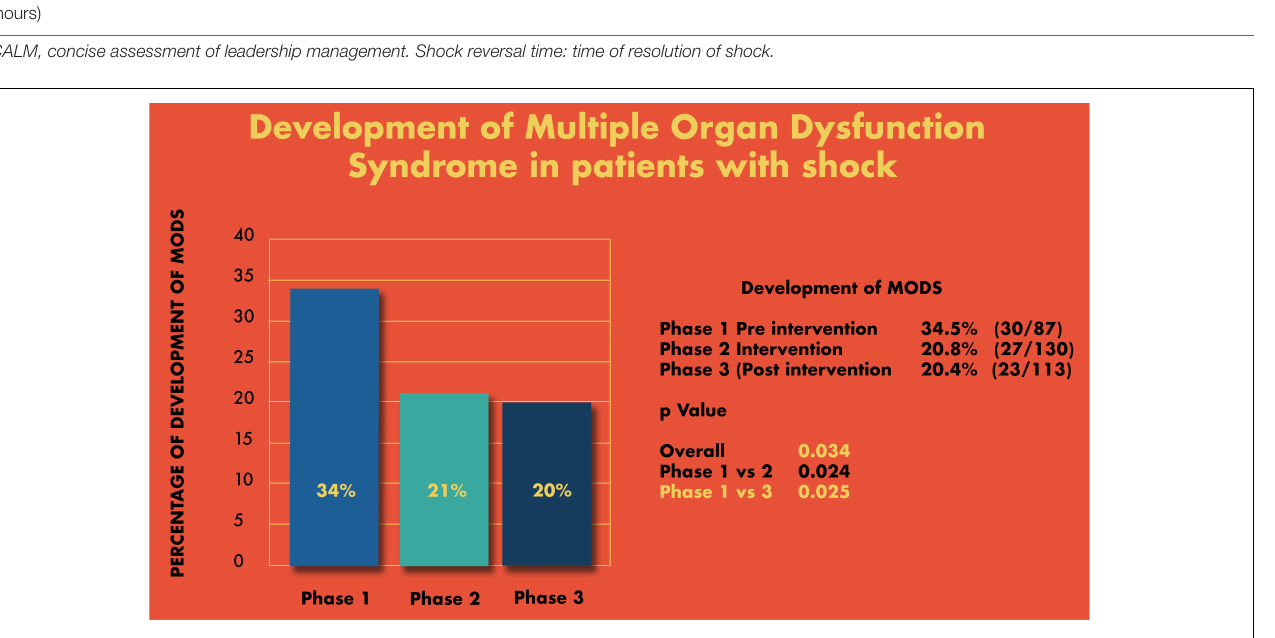
Intervention phase median (IQR)